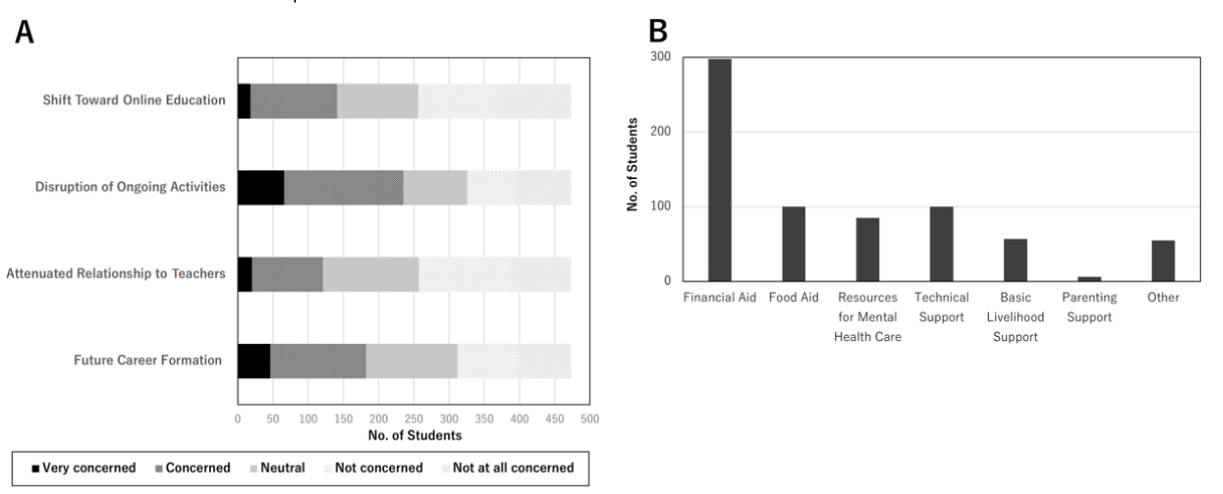
Figure 1. (A) The breakdown of medical students' educational concerns related to COVID-19. (B) What medical students want from the university upon the second wave the COVID-19